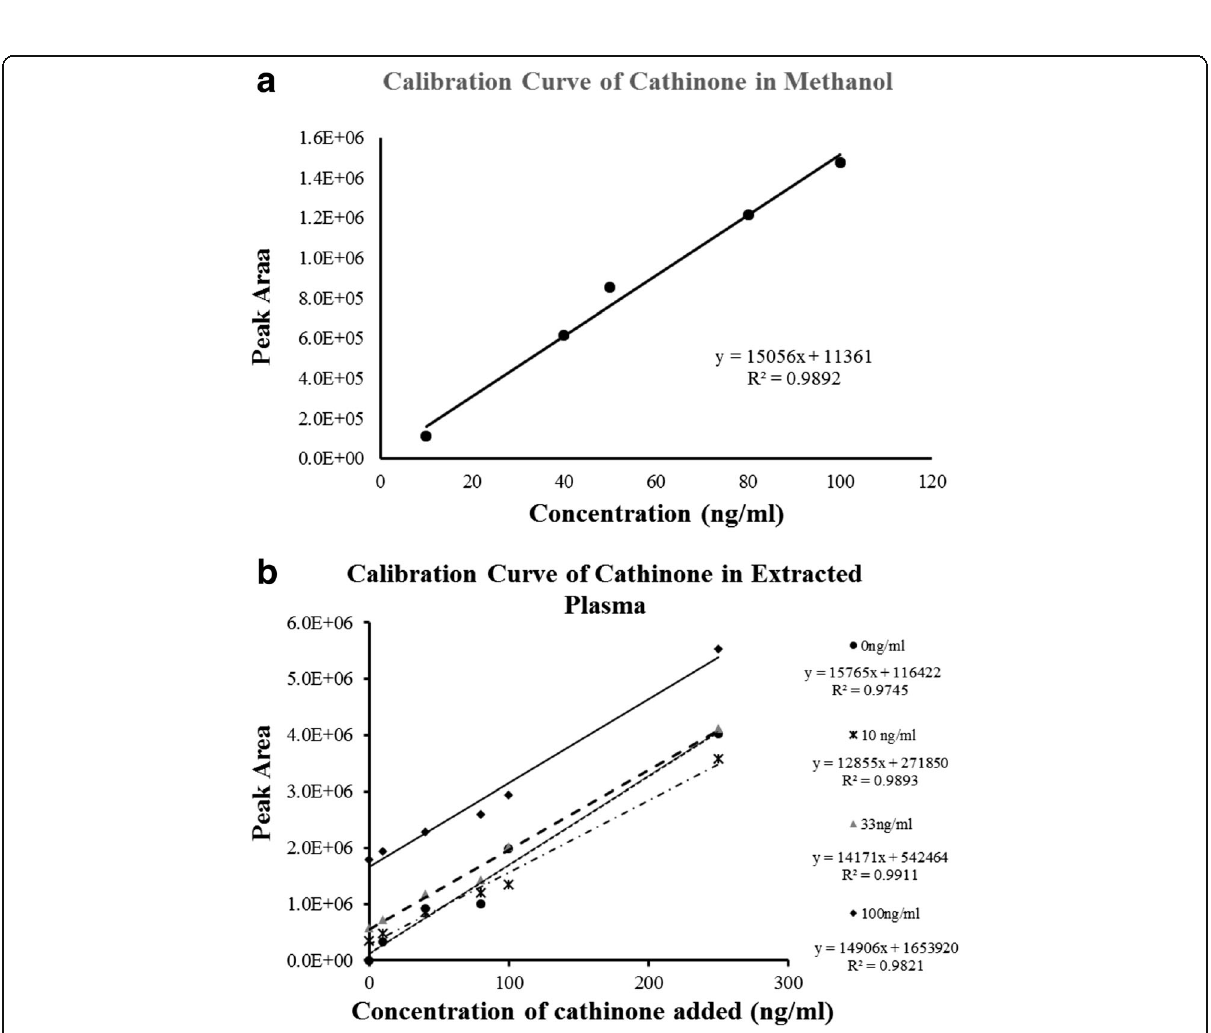
Fig. 2 Calibration curves of cathinone in methanol ( a ) and in extracted plasma ( b